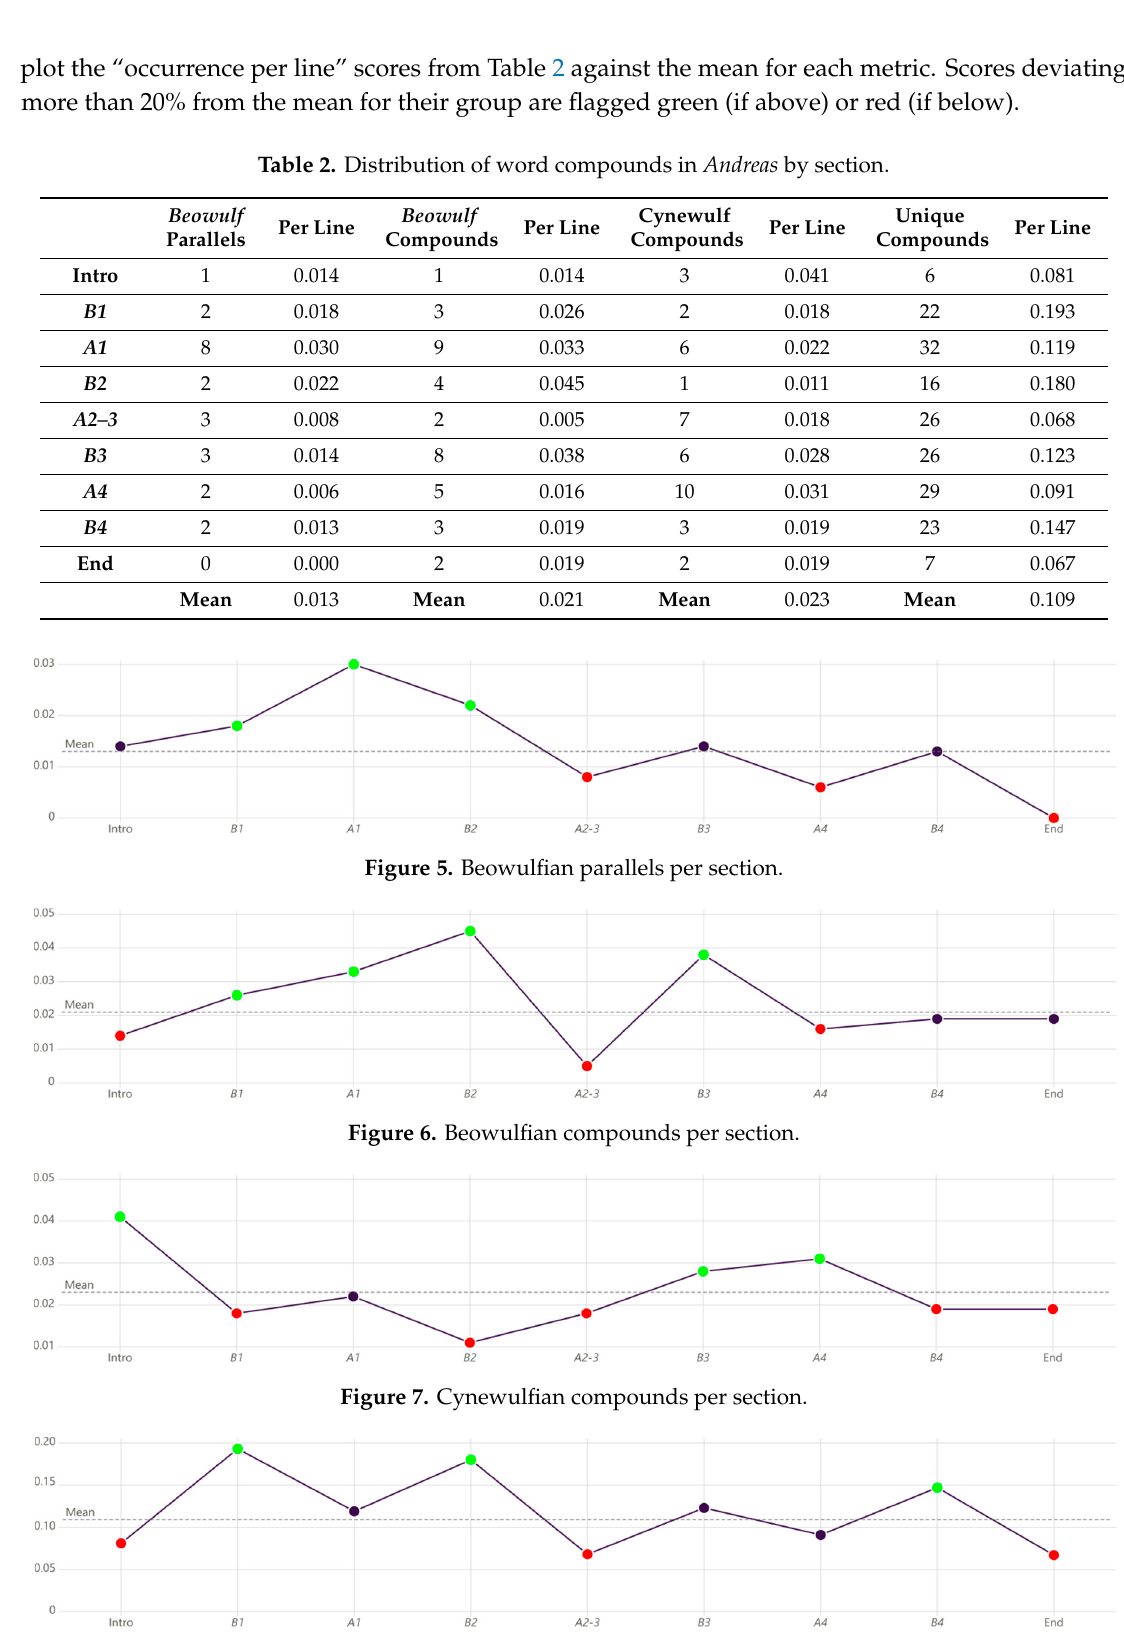
Table 2. Distribution of word compounds in Andreas by section.